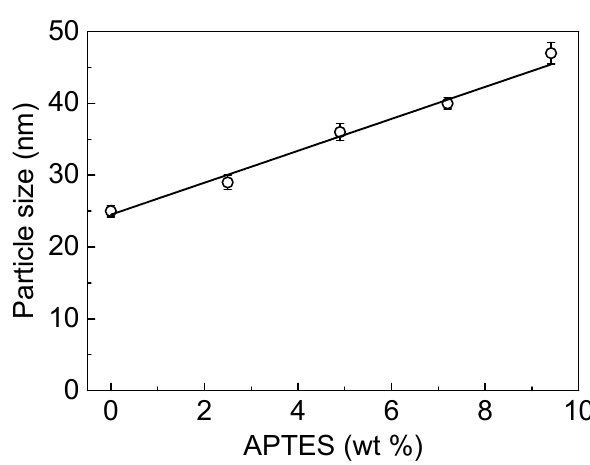
Figure 1. Particle sizes of DSPDs with different amounts of APTES.